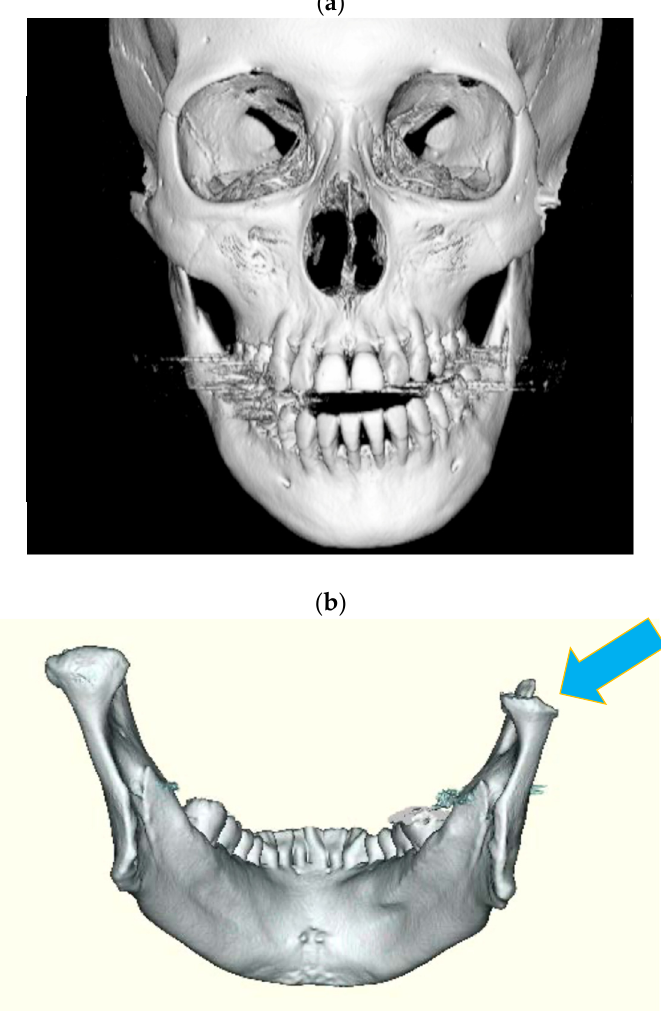
Figure 8. CT photographs of representative DJD-TMJ patients. ( a ) The anterior view of a 3D-reconstructed image of the CT showed the resorption of the left condyle and the mandibular deviation toward the left. ( b ) The posterior view of the 3D reconstructed mandible of another DJD-TMJ patient showed severe resorption in the right mandibular condyle (indicated by an arrow).